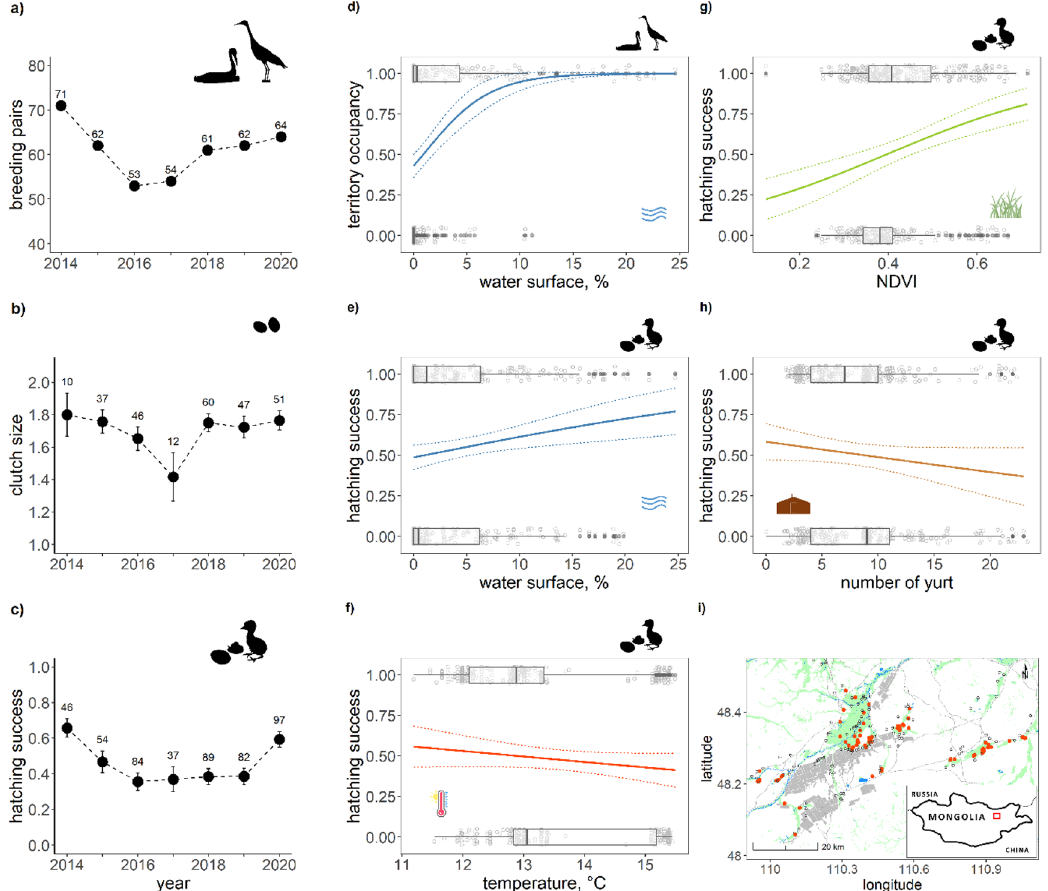
Figure 1. Breeding performance variation across the study period and significant explanatory variables for these variations in WNC. In panels ( a – c ) the total number of breeding pairs, average (± SE) clutch size and average (± SE) hatching success as a function of year are plotted with their respective sample sizes. In panels ( d – h ) significant relationships of these breeding performance indices with environmental factors are depicted (cf. Appendix Table A3), with distributions of explanatory variables presented as horizontal boxplots, including original data points (scattered grey dots) and outliers (black dots). In panel ( i ) a map of the study site is presented with wheat field in grey, wetlands in green and nest territories in red. All figures and maps were generated in RStudio v2022.02.2 (http:// www. rstud io. com) 61 WNCs took similar routes during southbound and northbound migrations. Birds departed their breeding sites from mid-September through mid-October heading southeast to their major stopover sites at the upper reaches of the Luan River in northern China, where 78% of individuals stayed on average 14 days. Next, they moved south to Bohai Bay (Beidangang or Yangcheng reservoirs near Tianjin) where some individuals spent a day while others continued moving further south. Then they moved on to the Yellow River basin where some individuals stopped for a few days before moving on to their main wintering sites at Poyang Lake. Birds arrived at their wintering sites from mid-October through mid-December. After spending the winter at Poyang Lake, birds started departing north again from late February until late March. Their first stop was at different parts of the Yellow River basin where birds stayed for a few hours to 3 days, while a few migrated directly to Bohai Bay for a stopover varying in time for a few hours to up to 13 days. Their next stop was at the upper reaches of the Luan River where they staged for an average of 20 days before heading north to the Mongolian breeding grounds. Birds arrived at the breeding grounds over a two-month period spanning early April until the first days of June (see summary in Fig. 2). Along the migration route of the western population, we found up to 31 stopover sites where cranes had stayed for more than two days. Five of these sites were clustered along the Luan River. WNCs tended to use a greater number of stopover sites during northbound compared to southbound migration. The duration of northbound migration was typically longer (median = 35 days, min = 22, max = 91, n = 18) than the duration of southbound migration (median = 29 days, min = 5, max = 78, n = 25). Variation in migration phenol- ogy across years showed that northbound migration in 2016 was particularly long (median = 65 days, min = 53, max = 82, n = 4) with the first individual arriving at the breeding grounds at least three weeks later than the first arrivals in other years. In that year cranes not only spent more time at stopovers during their northbound but also their southbound migration (Fig. 3).